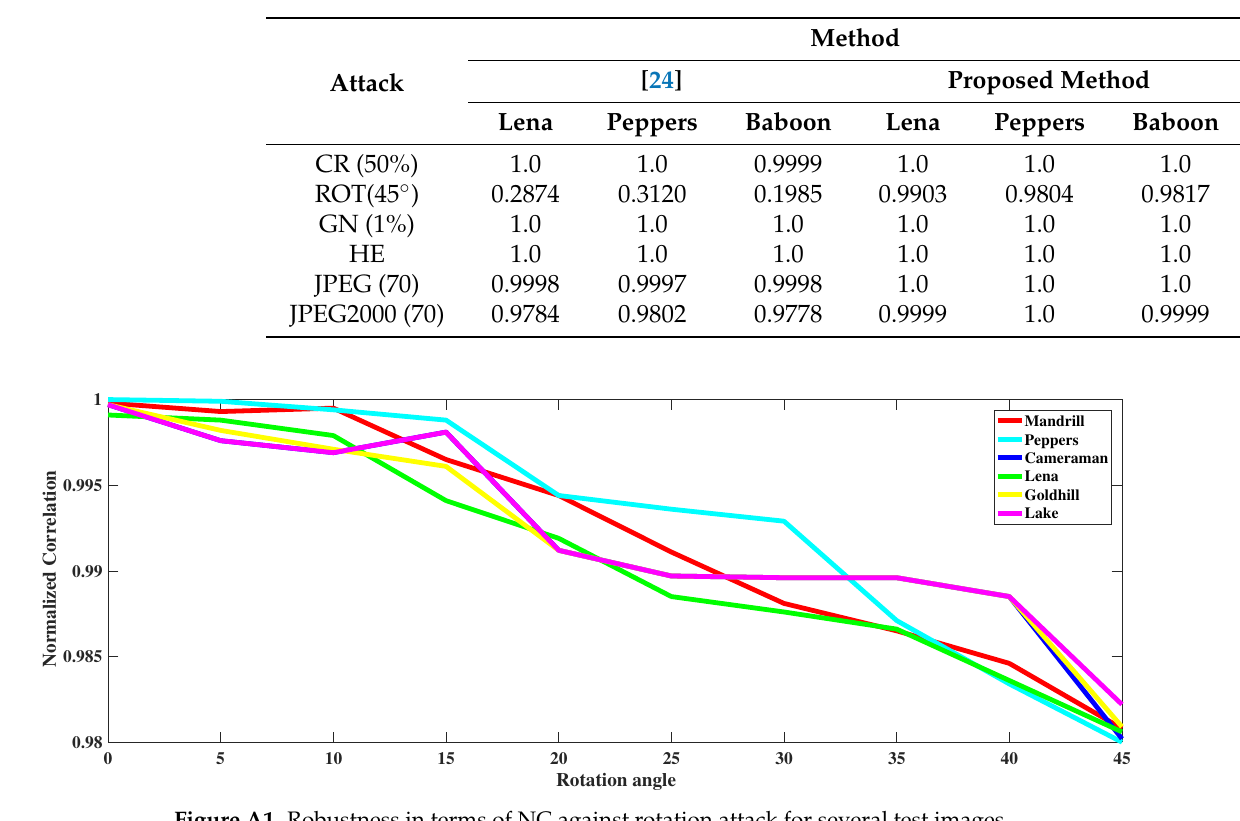
Figure A1. Robustness in terms of NC against rotation attack for several test images.